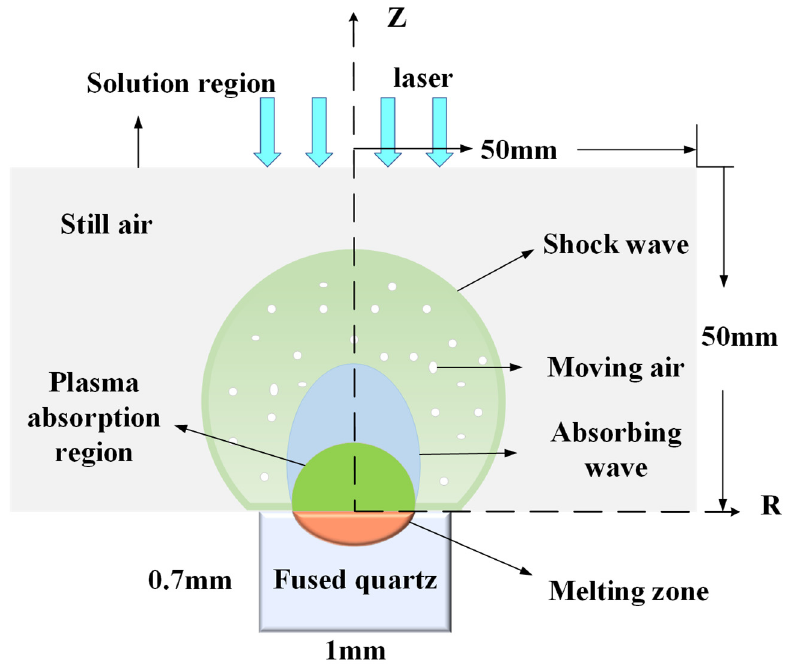
Figure 1. Simulation diagram of plasma and absorbing waves produced by laser-induced fused quartz.